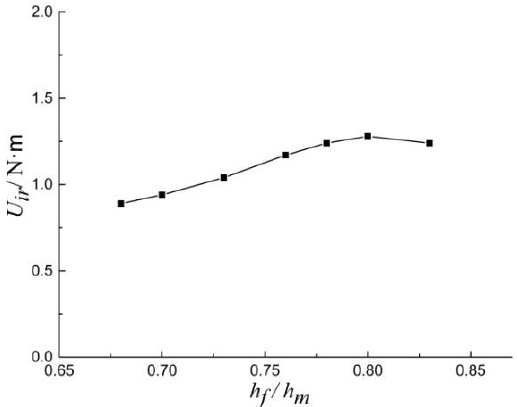
Figure 14. U ir versus h f / h m generated with the Berkovich indenter.